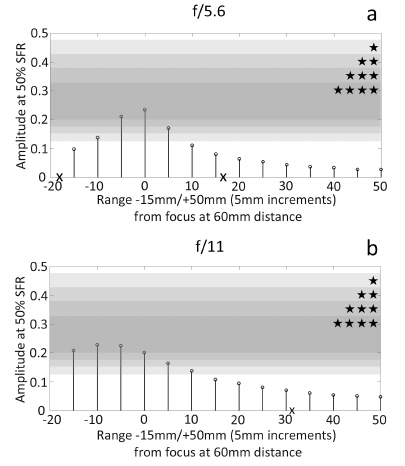
Figure 5. SFR50 for f/5.6 (a) and f/11(b) image sets. Grey gradients and stars indicate FADGI star ratings quality range and “x” on x-axis marks calculated design